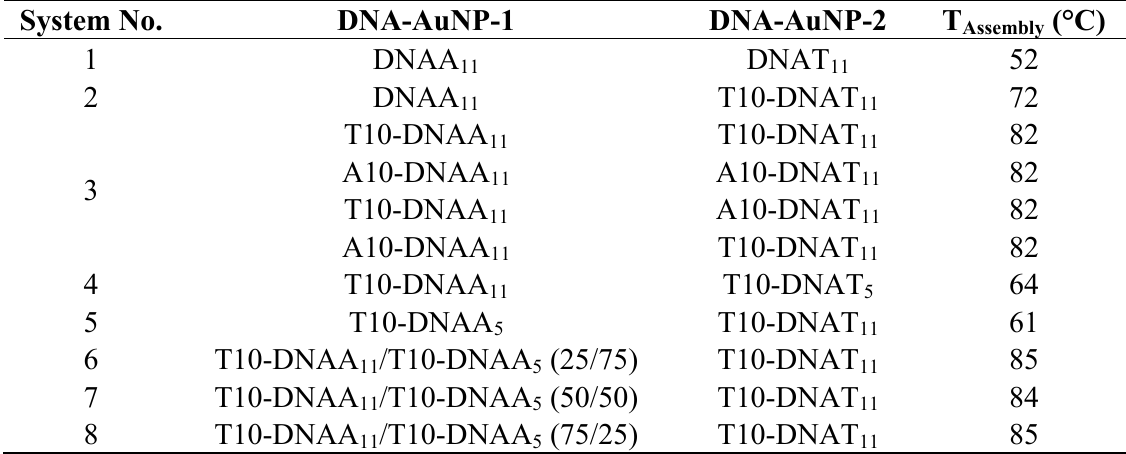
Table A1. Characteristic assembly temperature (±1 °C) of the different systems obtained by mixing AuNPs with complementary oligonucleotide strands. System No.